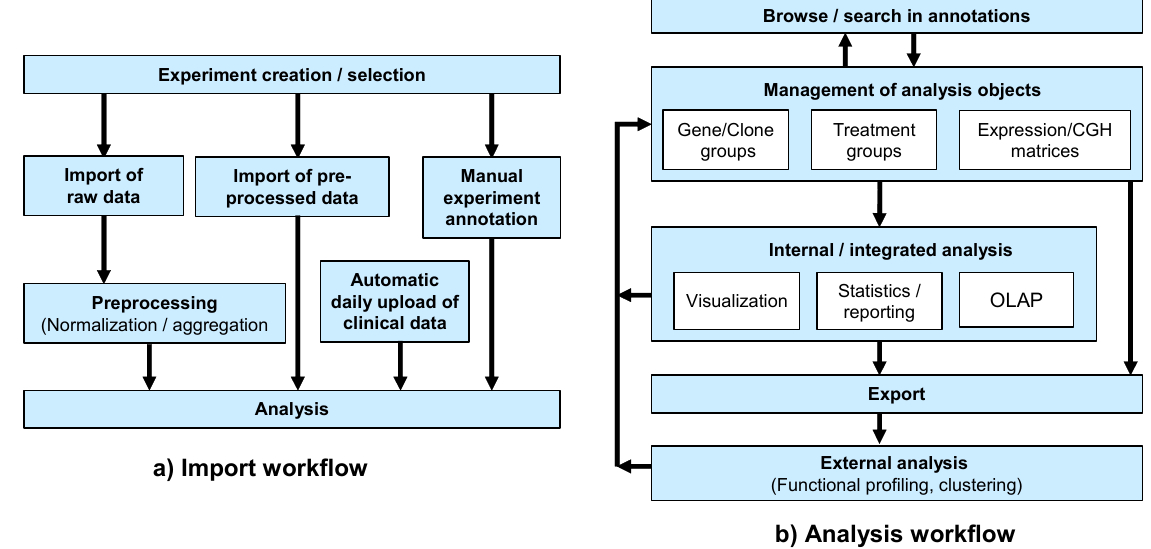
Figure 2: Operational workflows in